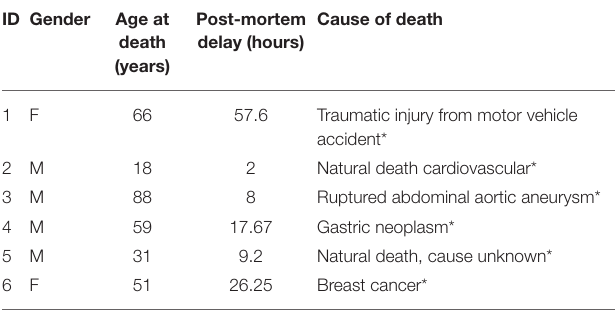
TABLE 2 | Non-epilepsy controls from necropsy.